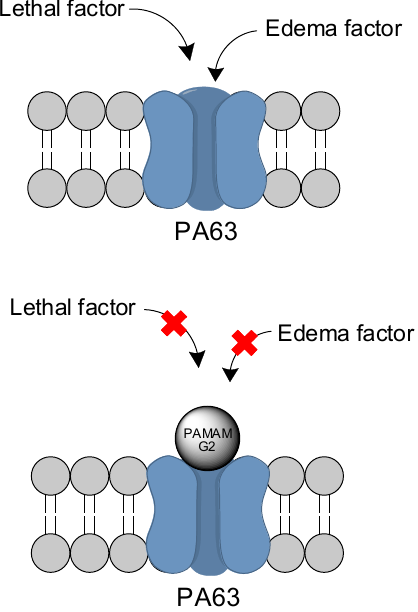
Figure 15. Blockage of the PA63 channel by PAMAM compounds [129].